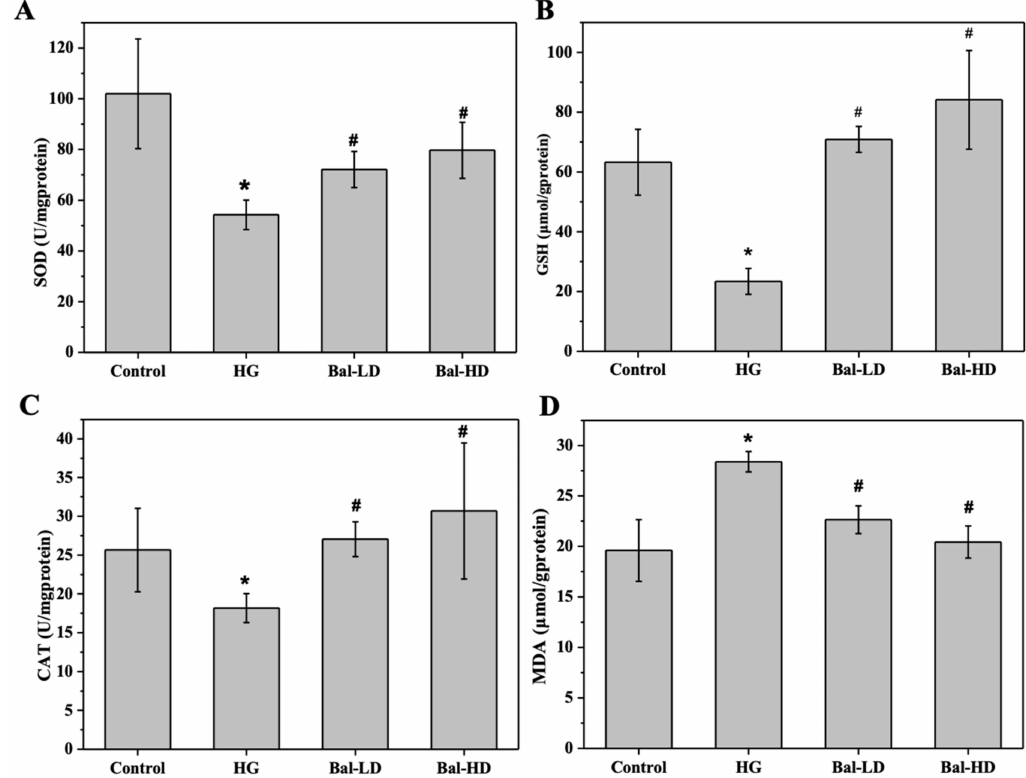
Figure 2. The e ff ect of baicalein on the biomarkers of oxidative stress in HL-7702 cells stimulated with 60.5 mM of glucose. The levels of superoxide dismutase (SOD) ( A ), catalase (CAT) ( B ), GSH ( C ), and malondialdehyde (MDA) ( D ) were determined by the corresponding assay kit. The data were presented as the mean ± SD ( n = 3). * p < 0.05 vs. control group; # p < 0.05 vs. HG group. The levels of biomarkers for oxidative stress in the liver tissues of T2DM mice receiving baicalein treatment for 8 weeks were determined and similar results were observed. The levels of SOD, CAT, and GSH were significantly decreased and the level of MDA was increased in DM group compared to the control group ( p < 0.05). Treatment of the mice with 40 mg / kg / d (Bal-LD) and 160 mg / kg / d (Bal-HD) of baicalein for 8 weeks significantly improved the levels of SOD, CAT, and GSH, and decreased the level of MDA ( p < 0.05) (Figure